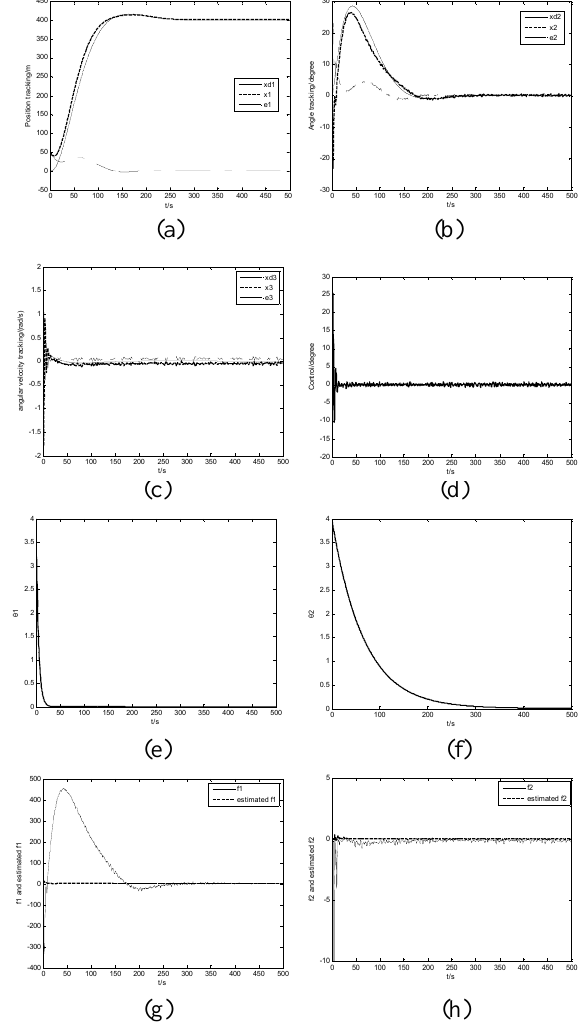
Fig. 4. Simulation results of the DES path tracking in case I. (a) sway displacement (b) yaw angle (c) yaw rate (d) control rudder angle (e)